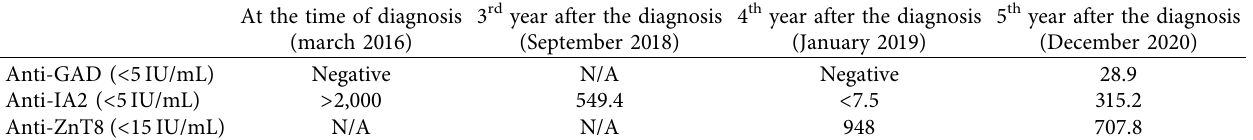
Table 1: Sequential pancreatic autoantibodies from the initial diagnosis to the fifth year of the development of T1DM. At the time of